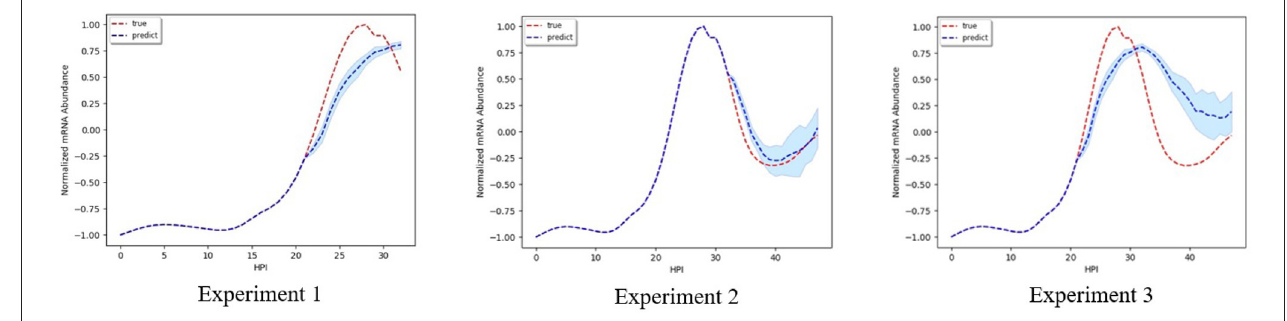
FIGURE 5 | Forecast series for Dihydrolipoyl dehydrogena.